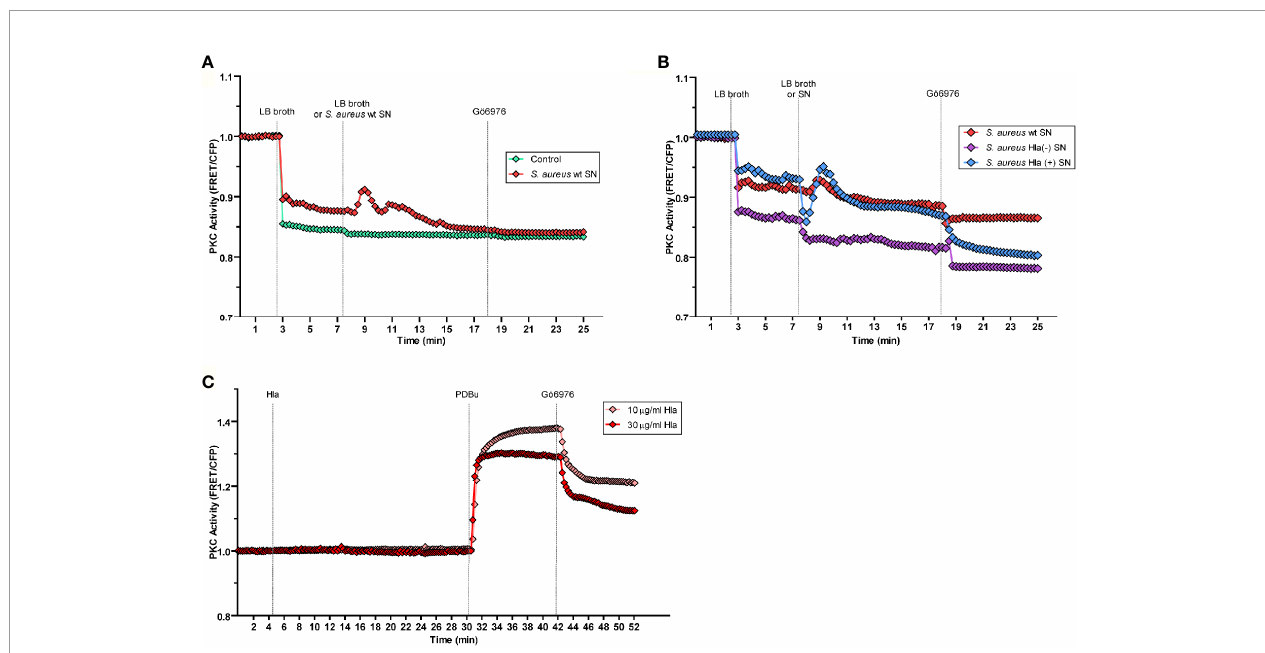
FIGURE 5 | PKC a is activated by the virulence factors secreted by S. aureus . By the use of a genetically encoded biosensor, the C kinase activity reporter (CKAR2), PKC activity was assessed as indicated in Material and Methods. (A) CHO cells co-expressing CKAR2 and mCherry-PKC a were treated with LB broth to set a baseline. After 5 minutes of stable baseline, they were treated with S. aureus wt culture supernatant (red line) and then treated with the PKC inhibitor Gö6976 (1 µM). The control condition (green line) corresponds to LB broth. (B) CHO cells co-expressing CKAR and mCherry-PKC a were treated with LB broth to settle a baseline, then, after 5 minutes they were treated with S. aureus wt (red line), S. aureus Hla ( – ) (blue line) or S. aureus Hla ( – )+pHla (violet line) culture supernatants and then treated with the inhibitor Gö6976 (1 µM). (C) CHO cells co-overexpressing CKAR2 and mCherry-PKC a were treated with 10 µg/ml (pink line) or 30 µg/ml (red line) of a -hemolysin pure protein. After 25 minutes, cells were treated with the PKC agonist PDBu (200 nM) and 12 minutes afterward, the PKC inhibitor Gö6976 (1 µM) was added. Data are the mean of three independent